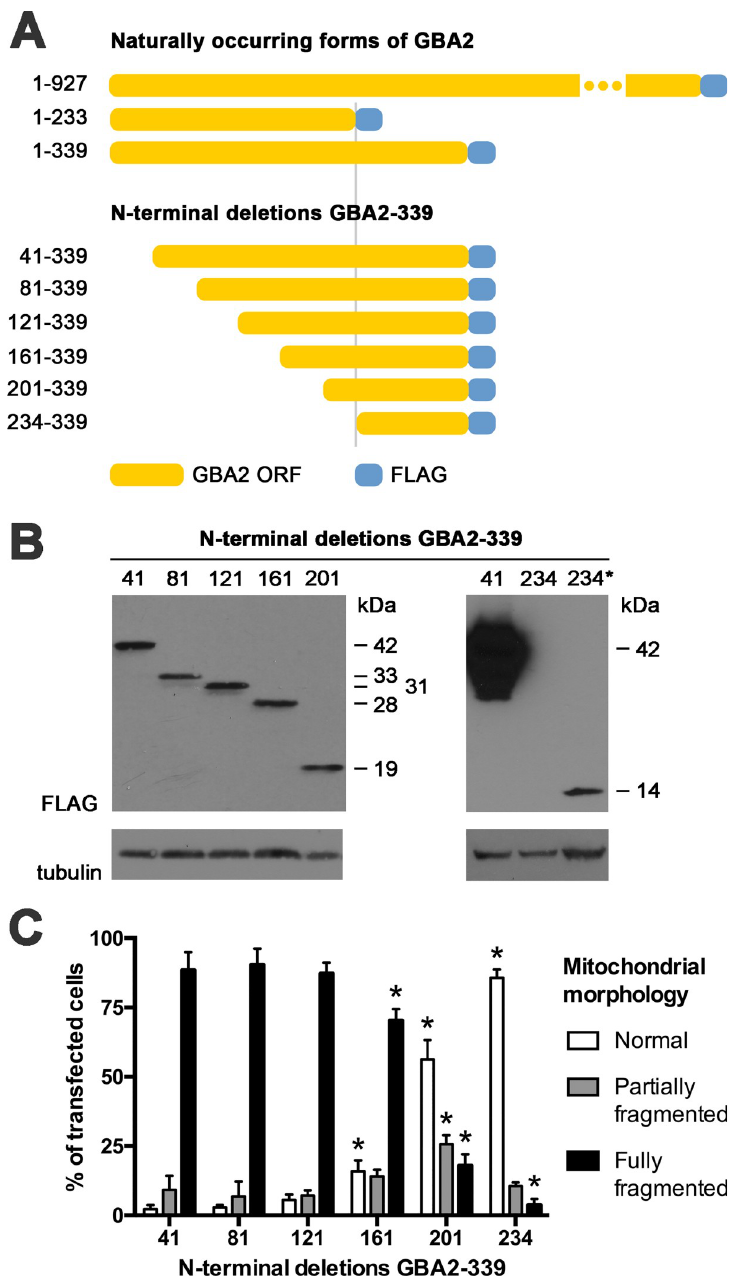
Fig 7. Identification of a mitochondrial targeting domain in GBA2. (A) Schematics of mutant versions of GBA2- 339-FLAG carrying increasingly large N-terminal deletions, lacking 40, 80, 120, 160, 200, and 233 amino acids (GBA2 [41–339] to GBA2[234–339]); schematics of GBA2-WT, GBA2-233, and GBA2-339 are depicted for reference (schematics drawn to scale, except GBA2-WT). (B) Western blot showing expression of N-terminal deletion mutants depicted in [A] in U2OS cells, “41” indicating GBA2[41–339], etc. Left panel, 8% polyacrylamide gel, 12 μ g protein per lane. Right panel, 12.5% polyacrylamide gel; “41” and “234”, 10 μ g protein; “234 � ”, 30 μ g protein. Apparent molecular weights are indicated. (C) Distribution of mitochondrial phenotypes in cells expressing different N-terminal deletion mutants of GBA2-339. Data indicate means + SD; at least 250 cells were scored in each of three independent experiments. Asterisk: significantly different compared to cells expressing GBA2[41–339], determined via one-way ANOVA.